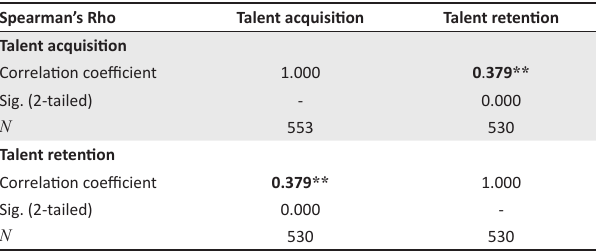
TABLE 9: Correlation between talent acquisition and talent